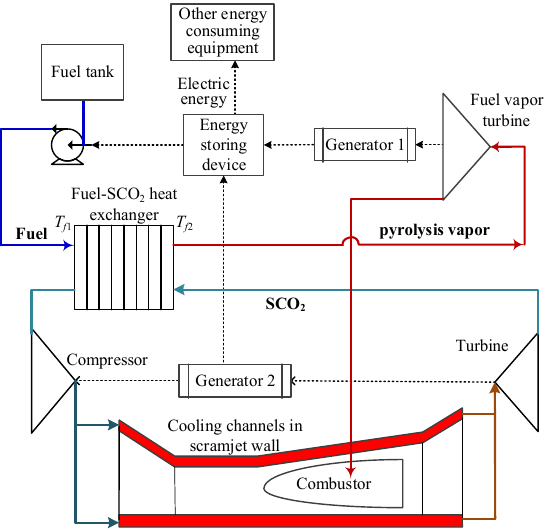
Figure 1. Scheme of PTMS based on SCO 2 closed Brayton cycle.